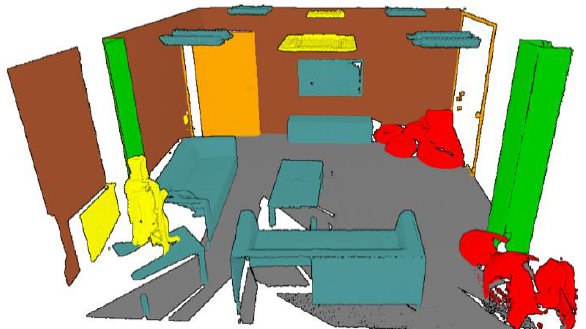
Figure 5. Classification results: a piece with different objects.